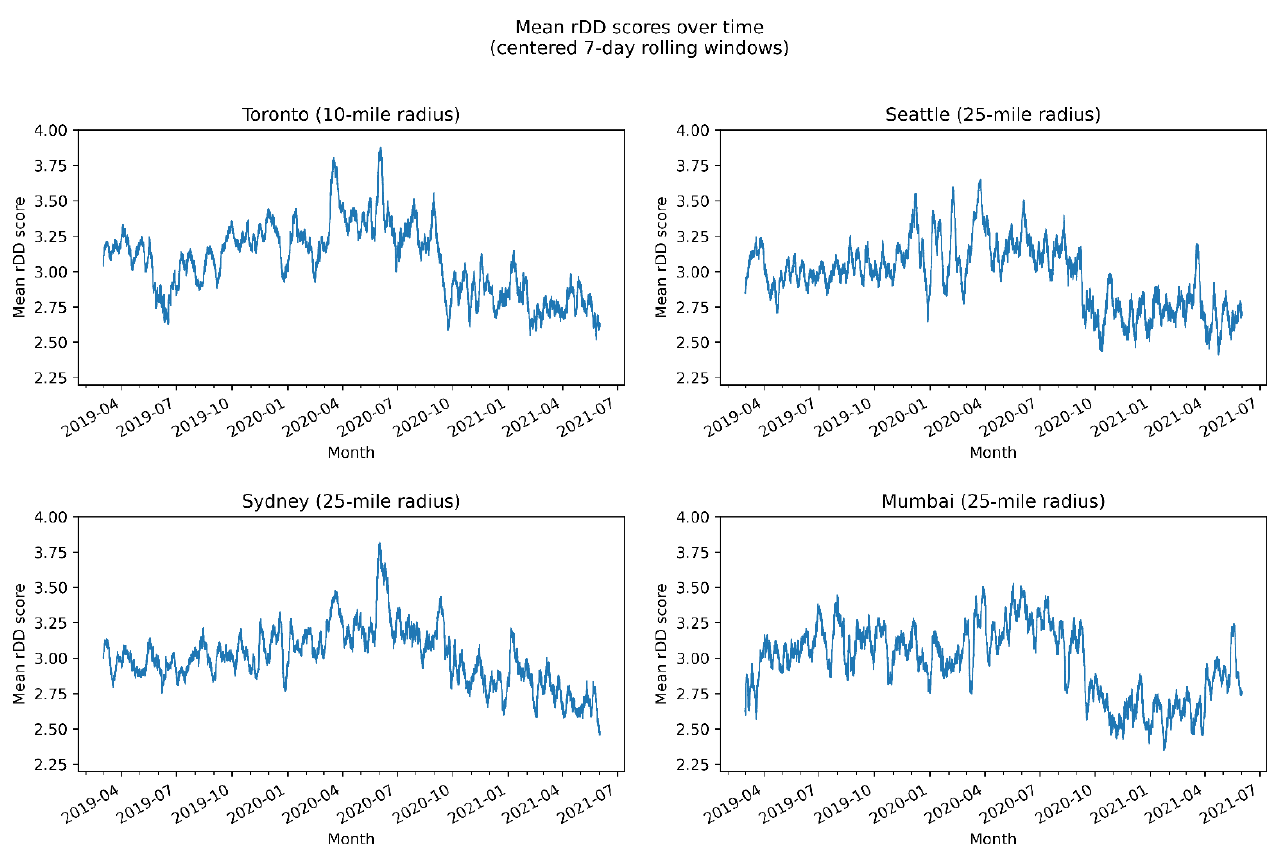
Figure 1: rDD scores over time for each city between April 2019 and June